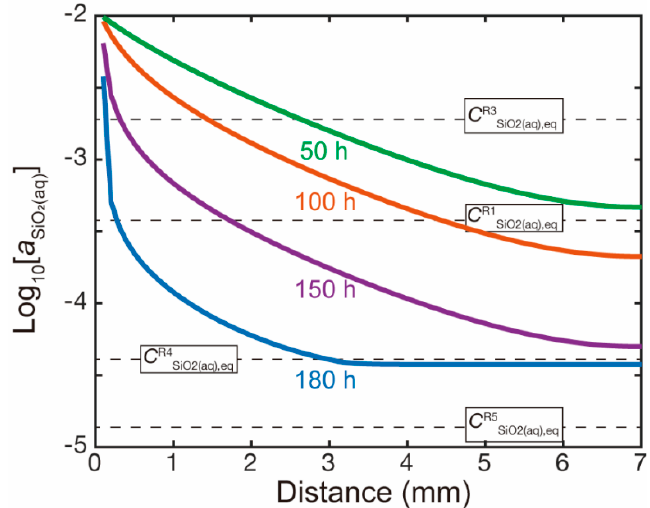
Figure 5. Spatiotemporal evolution of silica activity (a SiO2(aq) ) predicted using the reactive transport model (Equation (8), with the parameters given in Section 3). a SiO2(aq) (and thus C SiO2(aq) ) is always larger than C R5SiO2(aq),eq .